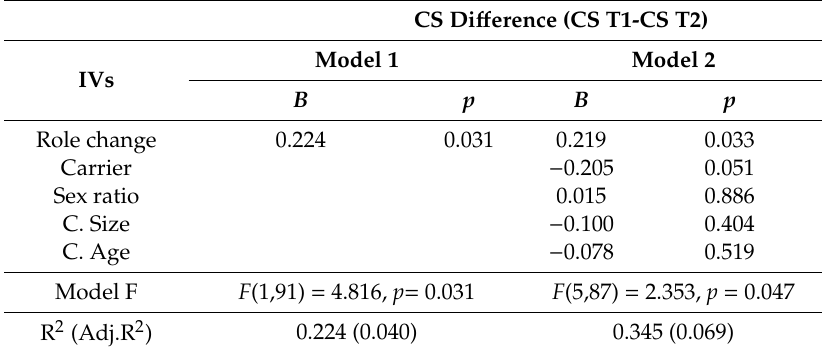
Table 7. Hierarchical regression for predicting CS di ff erences, including class variables (Group 3: Bully / victim